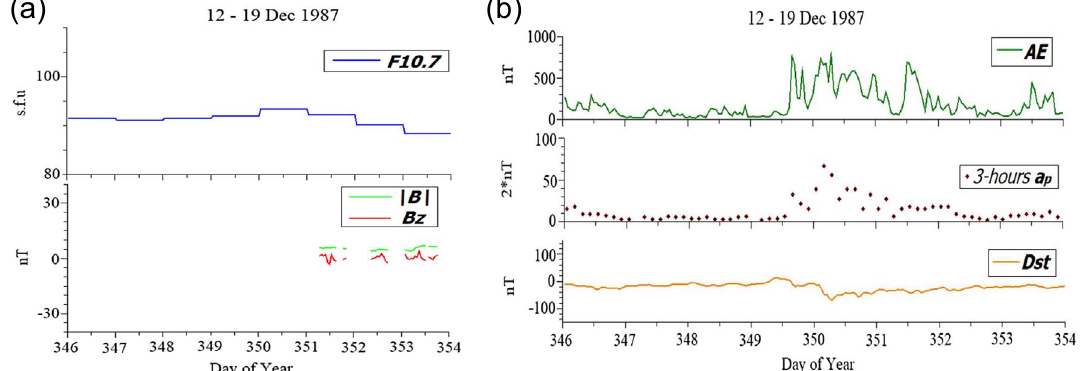
Fig. 8. In panel (a) is described, from up to down, Solar fl ux F10.7 from 12 to 19 December 1987, and, for the same time period, the behaviour of the magnitude and the Z component of the IMF. Panel (b) shows, from up to down, the AE , the a p and the Dst indices, from 12 to 19 December 1987. (The hourly AE index data are retrieved through the Kyoto AE index service http://wdc.kugi.kyoto-u.ac.jp/dstae/index.html. Three-hour a p data are provided by NOAA ftp://ftp.ngdc.noaa.gov/STP/GEOMAGNETIC_DATA/INDICES/KP_AP. Dst and Solar data are